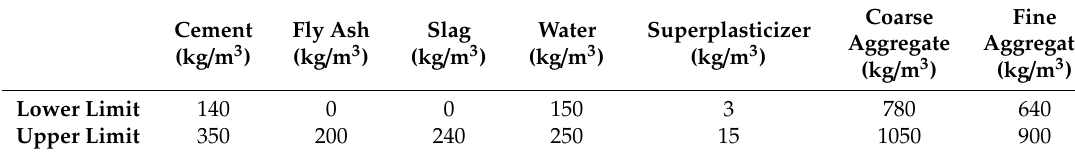
Table 2. The lower and upper limits of the concrete component [14].